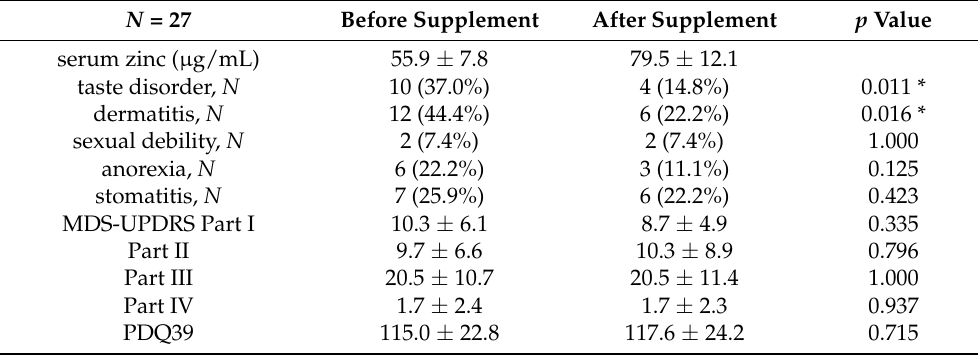
Figure 2. Symptoms before and after oral administration of zinc. In total, 27 cases with serum zinc less than 80 and symptom were supplemented with zinc, there were 15 cases in which zinc deficiency were improved. Table 4. Symptoms before and after oral zinc